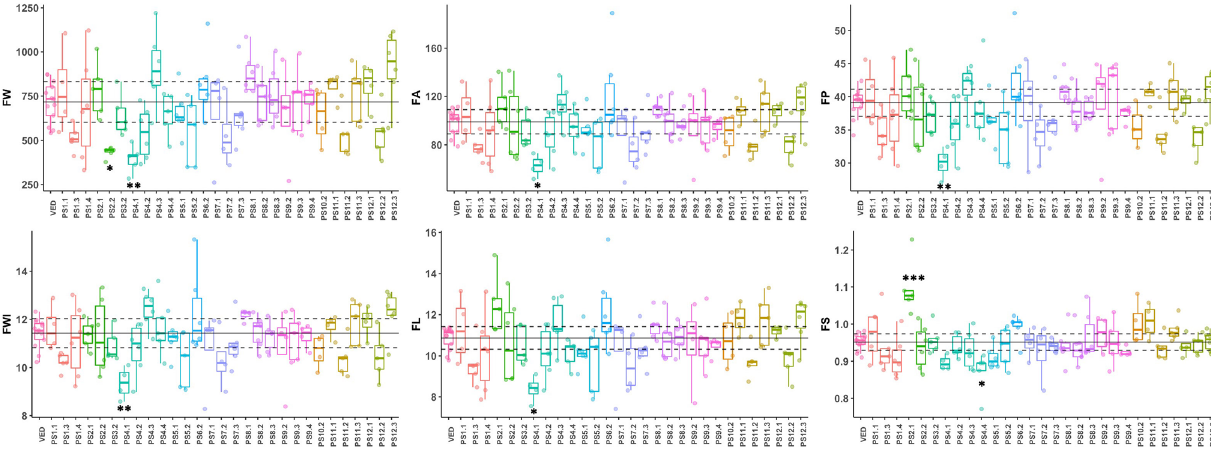
Figure 5. Boxplot representing the values of morphological traits for ILs in 2018. Each dot represents a replicate, the black solid line corresponds to the average and the grey dashed lines to the average ± SD of the recurrent parent Ved. Significant differences are marked with asterisks: *< 0.05, **< 0.01, ***<